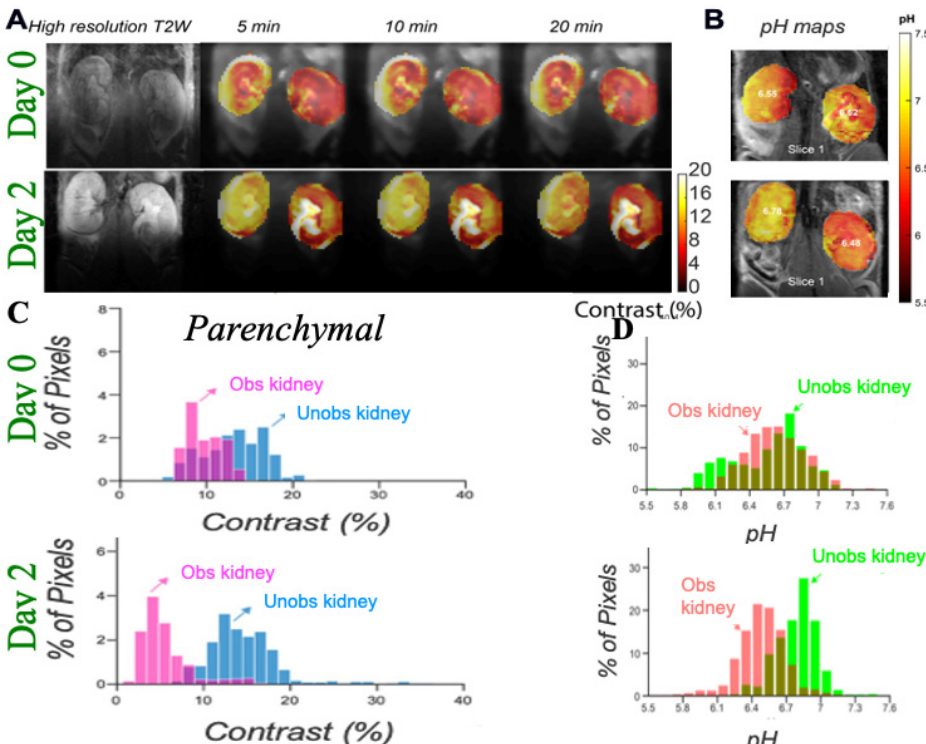
Figure 6. Imaging UUO in mice using iopamidol CEST MRI; ( A ) Representative T2w and CEST MRI contrast maps at 4.2 ppm on a UUO mouse with right kidney obstructed on day 0 and 2 post surgery with iopamidol dose = 1 g I/kg, B 1 =4 µ T, 2 offset protocol, as in reference [70], to minimize pH mapping time and allow averaging for the production of high contrast to noise ratio (CNR) motion artifact compensated CEST maps; Dynamic CEST images were acquired at offsets 4.2, 5.5 ppm repeatedly for 80 min using a CW RF saturation of duration 2.1 s (7 rectangular block pulses each of 300 ms with 10 µ s interpulse delay). TE/TR = 3.55/11,000 ms; Rapid Acquisition with Relaxation Enhancement with short echo time (RAREst) acquisition module and centric encoding were used. In total, 10 sets of M0 offsets at 40 ppm were acquired for normalization. Time interval between two dynamic CEST images was 44 s. Moving time average of 10 dynamic CEST images was performed to compensate the motion induced artifacts in CEST contrast with the B1 employed rendering the maps sufficiently insensitive to the B0 homogeneity across the kidneys shown in the B0 maps as described in reference [70]. The images depict differences in marker perfusion for left and right kidneys due to hydronephrosis and resulting functional impairment; ( B ) pH maps using images acquired 5 min after iopamidol administration. pH was calculated using the ratio of CEST contrast at 4.2, 5.5 ppm and the calibration curve obtained using the iopamidol phantom at pH values between 5.3 and 7.3; ( C ) Parenchymal contrast histograms which display reduced contrast for obstructed kidney cortex and a larger variation in contrast for the obstructed kidney calyx; ( D ) pH histograms which display an increase in ∆ pH over time after UUO first in obstructed kidney and later in unobstructed kidney which is similar to what was observed in MMA induced CKD in mice.